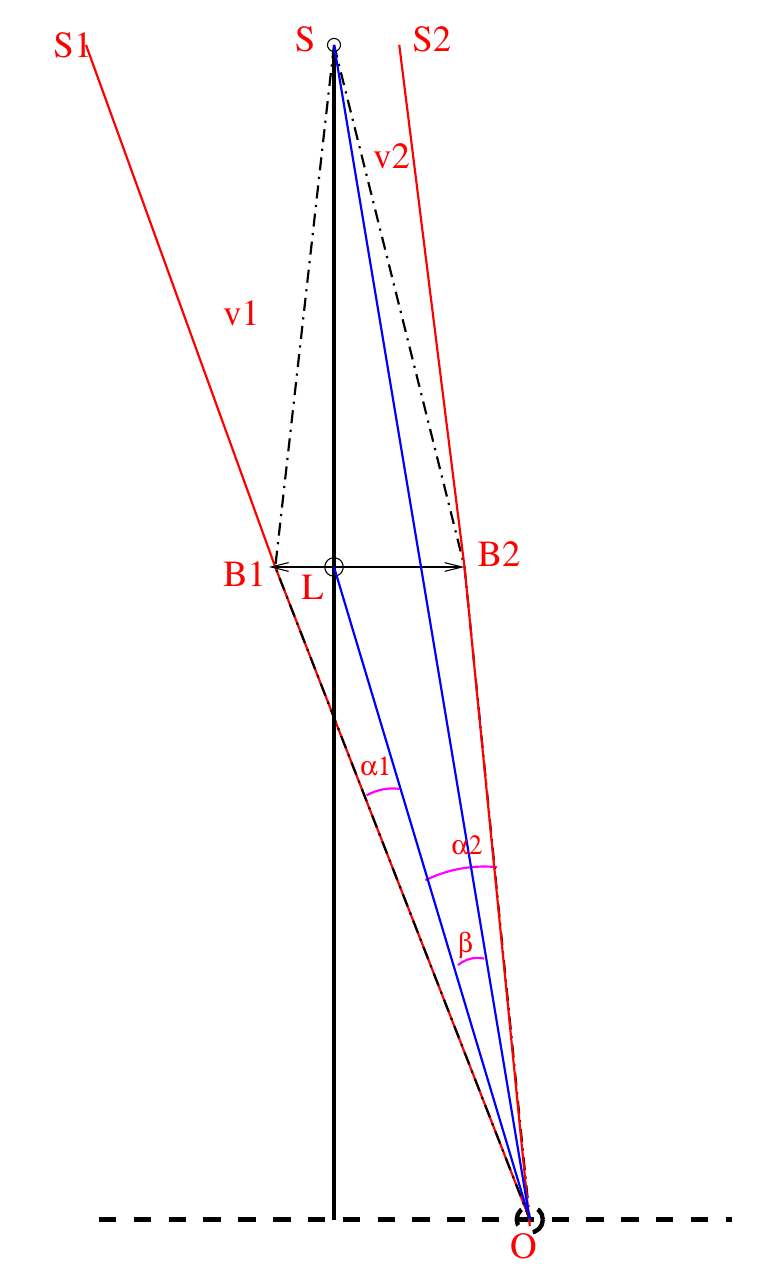
Figure 1. The geometry of a gravitational lens: The source at S when viewed from O appears at the locations S 1 and S 2 due to the deflections at B 1 and B 2 caused by the bending of the light by the lens at L . The angle SOL is β and S 1 OS 2 is the angle between the two images α = α 1 + α 2 . One restriction imposed by Refsdal [7,9] that can be dropped is that for neutrinos,